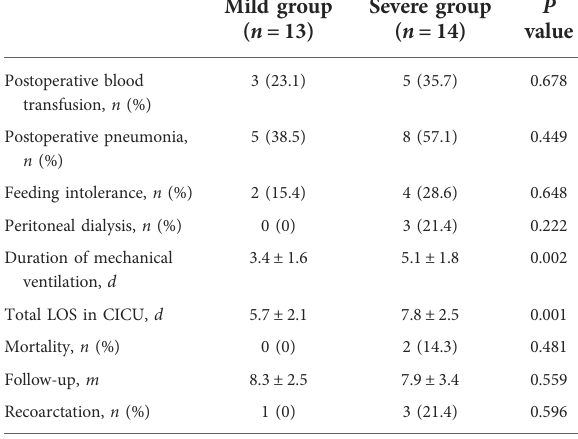
TABLE 2 Comparison of postoperative clinical results between the two groups.